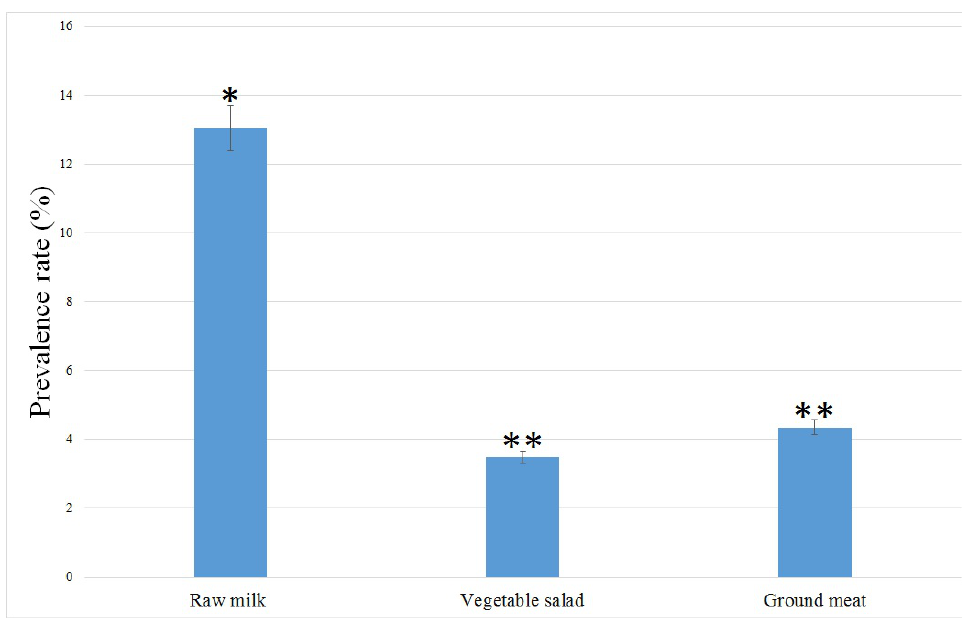
Figure 1. Prevalence rates of E. coli in different food samples collected from Qazvin province, Iran. * and ** indicates significant differences ( p > 0.05).